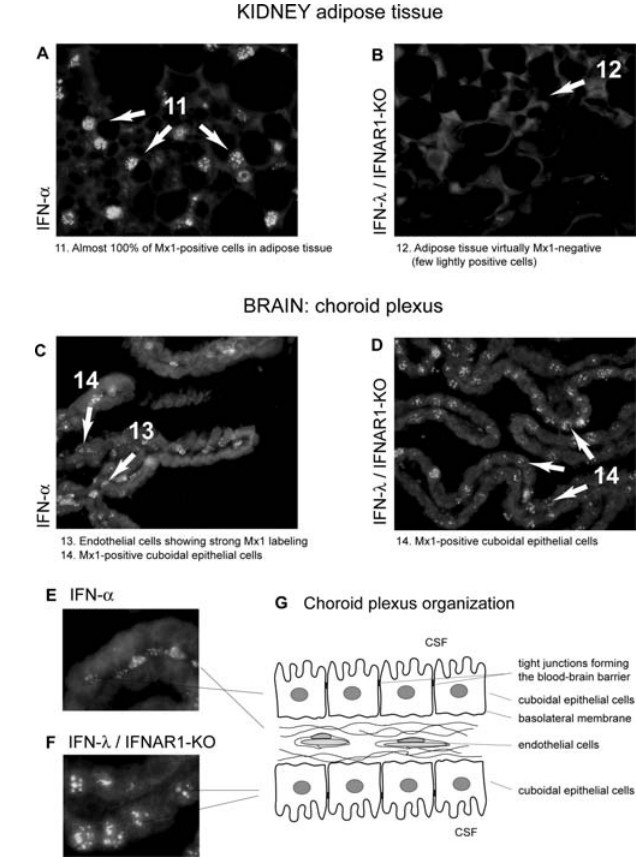
Figure 8. IFN- a and IFN- l responding cells in the kidney adipose tissue and in the brain. Mx1 expression, detected by immunohistochemistry (as white nuclear spots), 7 days after electro- injection of a plasmid coding for MuIFN- a 6T or MuIFN- l 3. A–C–E: Mx1/ WT mouse electroinjected with a plasmid coding for IFN- a 6T. B–D–F: Mx1/IFNAR1-KO mouse electroinjected with a plasmid coding for IFN- l 3. A–B: sections showing the kidney adipose tissue. C–D: brain sections showing the choroid plexus of the 4th ventricle. E–F: Higher magnification of the choroid plexus. G: Cartoon showing the structural organization of the choroid